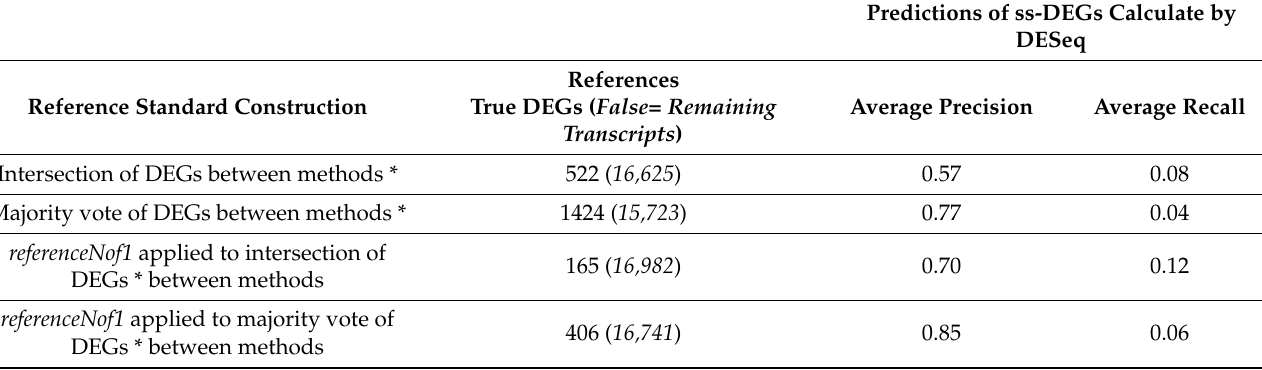
Table 5. Single-subject DEGs predictions evaluated by conventional methods and refereneNof1 . In order to simulate transcriptomic data from a single patient, single-subject DEGs were calculated by the DESeq method from two samples (MCF7 cell vs. MCF7 exposed to estrogen) and evaluated against two reference standards derived from Y samples in each condition (2Y samples total). The two reference standards constructed in this exemplary study illustrate the increases in accuracy provided by the proposed referenceNof1 method to increase the agreement between DEGs methods used for as a reference and mitigate analytical biases from isomorphic evaluations. The optimal region identified by the referenceNof1 algorithm resulted in a DESeq prediction set with a substantially higher precision with a slightly higher recall. (Legend: In the manuscript and figure, we represent FC for upregulated genes and 1/FC for downregulated